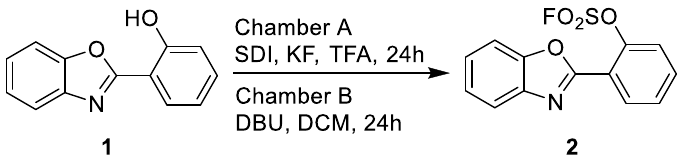
Scheme 1. Synthesis of title compound 2 .